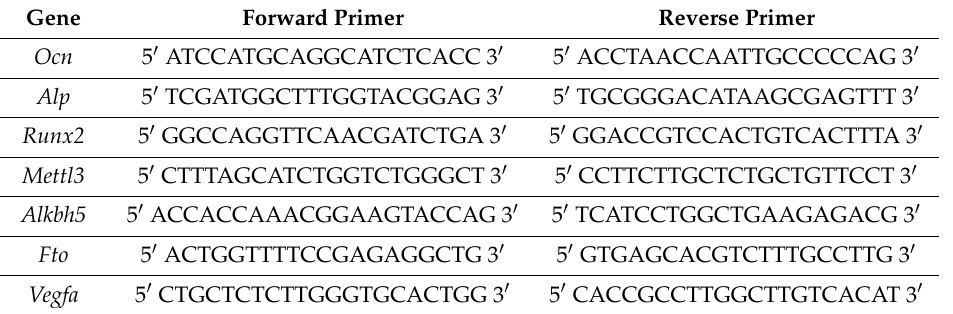
Table 1. Primers Used for the Analysis of mRNA Levels by qRT-PCR and